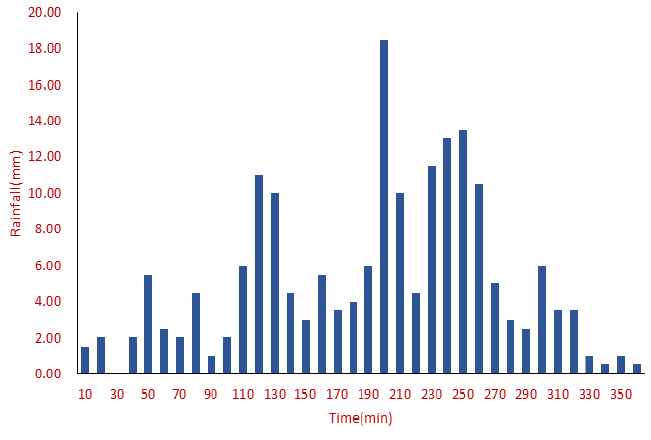
Figure 7. Observed rainfall on 27 July 2011. Table 8. Results of the simulation and prediction.